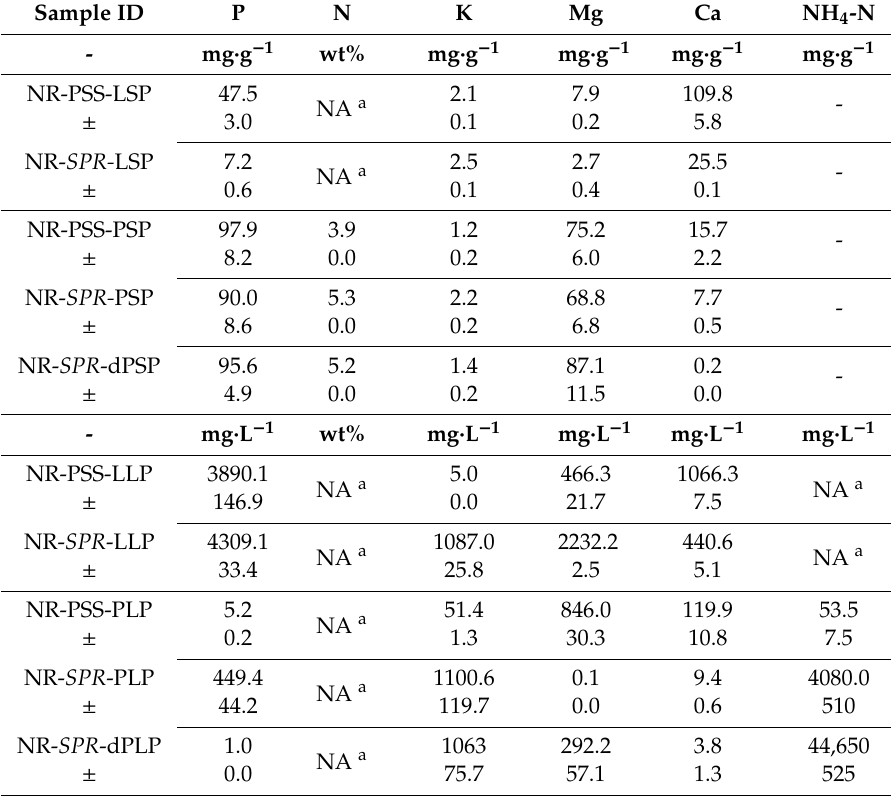
Table 2. Nutrient distribution in the streams circulated by phosphate